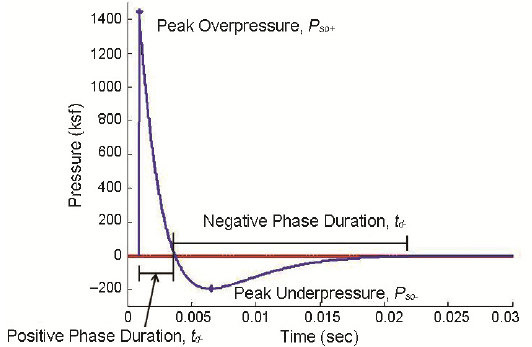
Fig. 3. Example pressure-time profile (1 ksf = 48